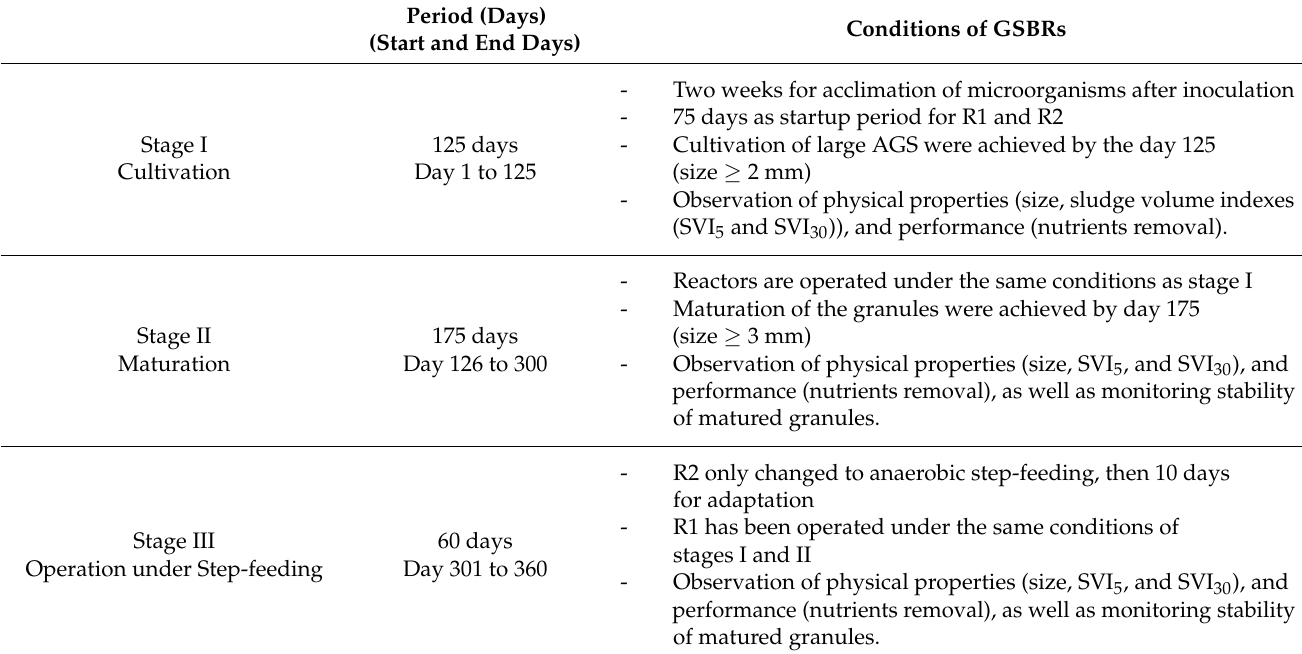
Table 1. Operation stages for R1 and